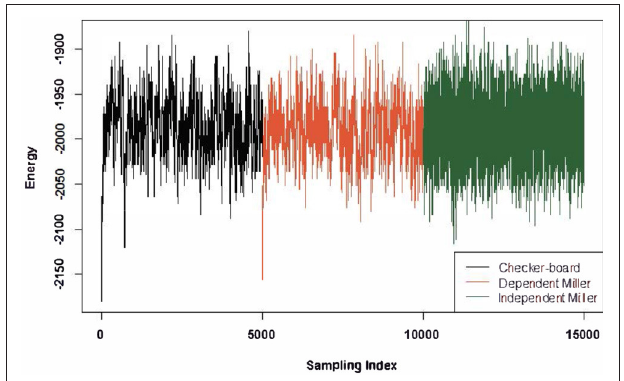
FIGURE 3 | Energies of a total of 15,000 sampling matrices with fixed row and column sums. The formula for energy is defined in S1 ( Supplementary Section 1 ). Three different colors represent the sampling methods used: 2 × 2 checkerboard, dependent Miller’s algorithm, and independent Miller’s